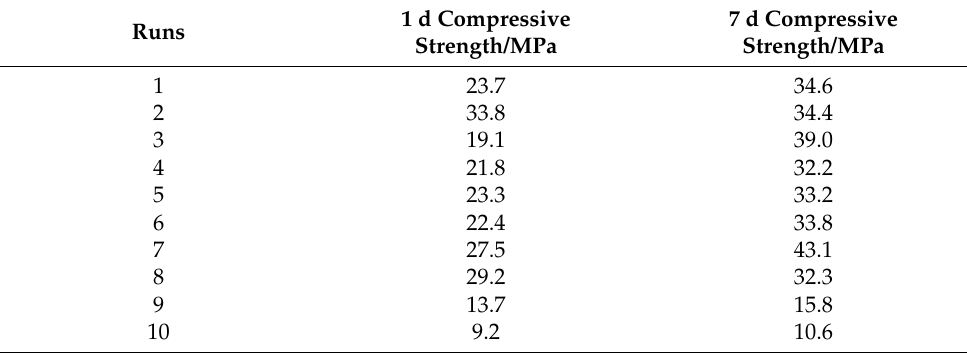
Table 11. The compressive strength of the cube